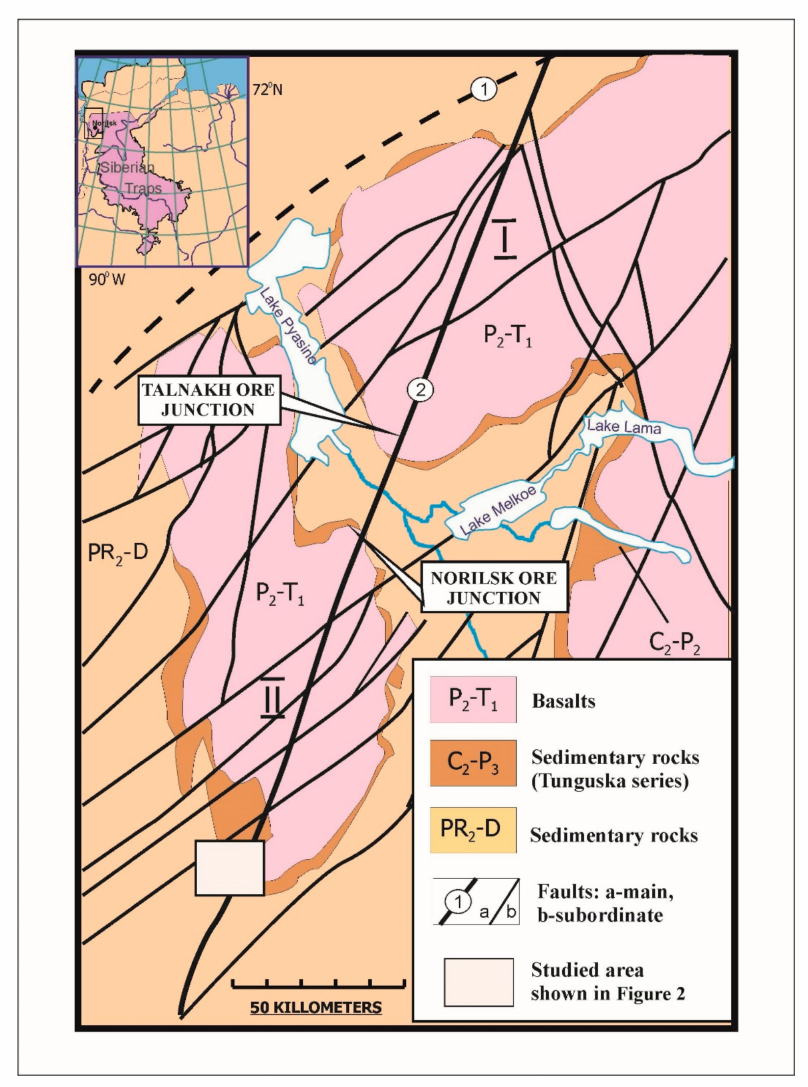
Figure 1. Geology of the Norilsk district (modified after [2]). Troughs: I—Kharaelakh, II—Norilsk; faults: 1—Yenisey-Khatangsky, 2—Norilsk-Kharaelakh. The sidebar shows the position of the Norilsk district within the Siberian traps